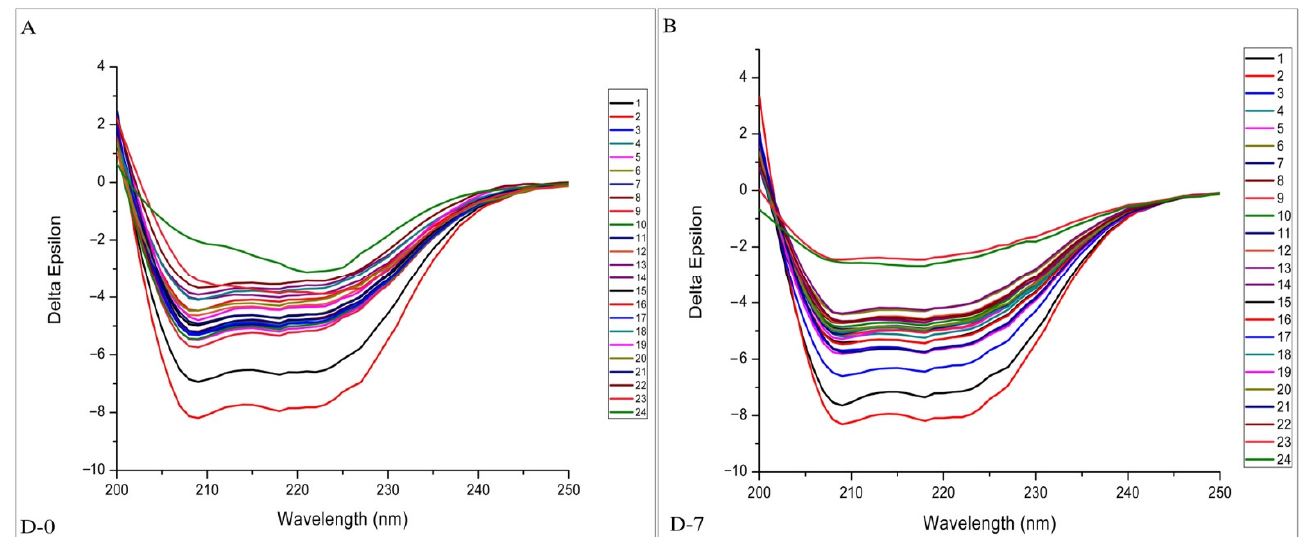
Figure 5. CD spectra of all samples (the numbers refer to the different samples reported in Materials and Methods) after incubation at T = 310 K recorded at day 0 (D-0) ( A ) and day 7 (D-7) ( B ). A lower delta epsilon value, and therefore an increase in alpha-helix content was observed for gHSA (red line) compared with native HSA (black line) at D-0 (Figure 5). Fur- thermore, increasing the incubation time, the α-helix percentage in HSA increased from 48% (D-0) to 55.4% (D-7), close to the α-helix content in gHSA, which is 57% (D-0) (Figure